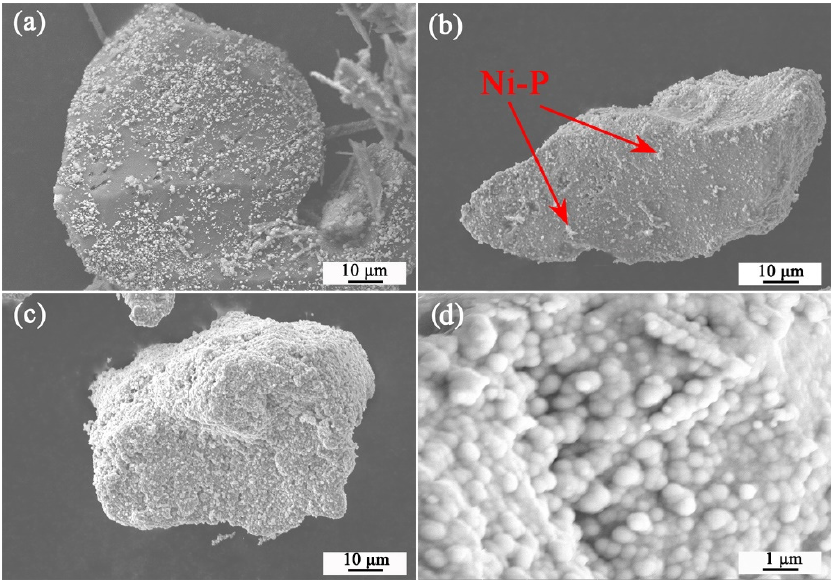
Figure 3. SEM images of the Ni–P layers with NaH 2 PO 2 ·H 2 O concentrations of ( a ) 10, ( b ) 20, and ( c ) 30 g/L. ( d ) Magnified image of ( c ).